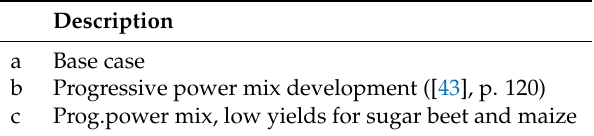
Table 2. Scenario summary. The base case (a) assumes a moderate power mix development according to ([43], p. 123), a wheat price increase of 4% a − 1 , GHG optimized process heat and medium yields for all crops. Scenario variations compared to the base case are